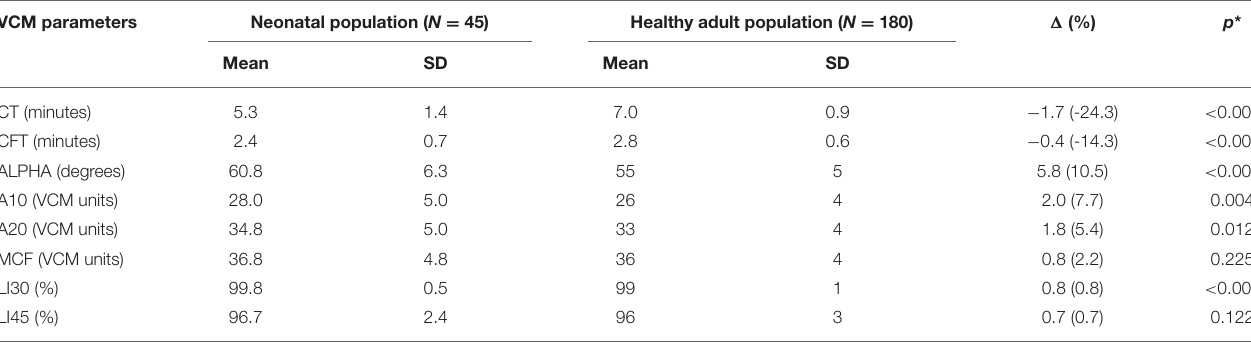
TABLE 3 | VCM profile, comparison between neonatal population and healthy adult population.